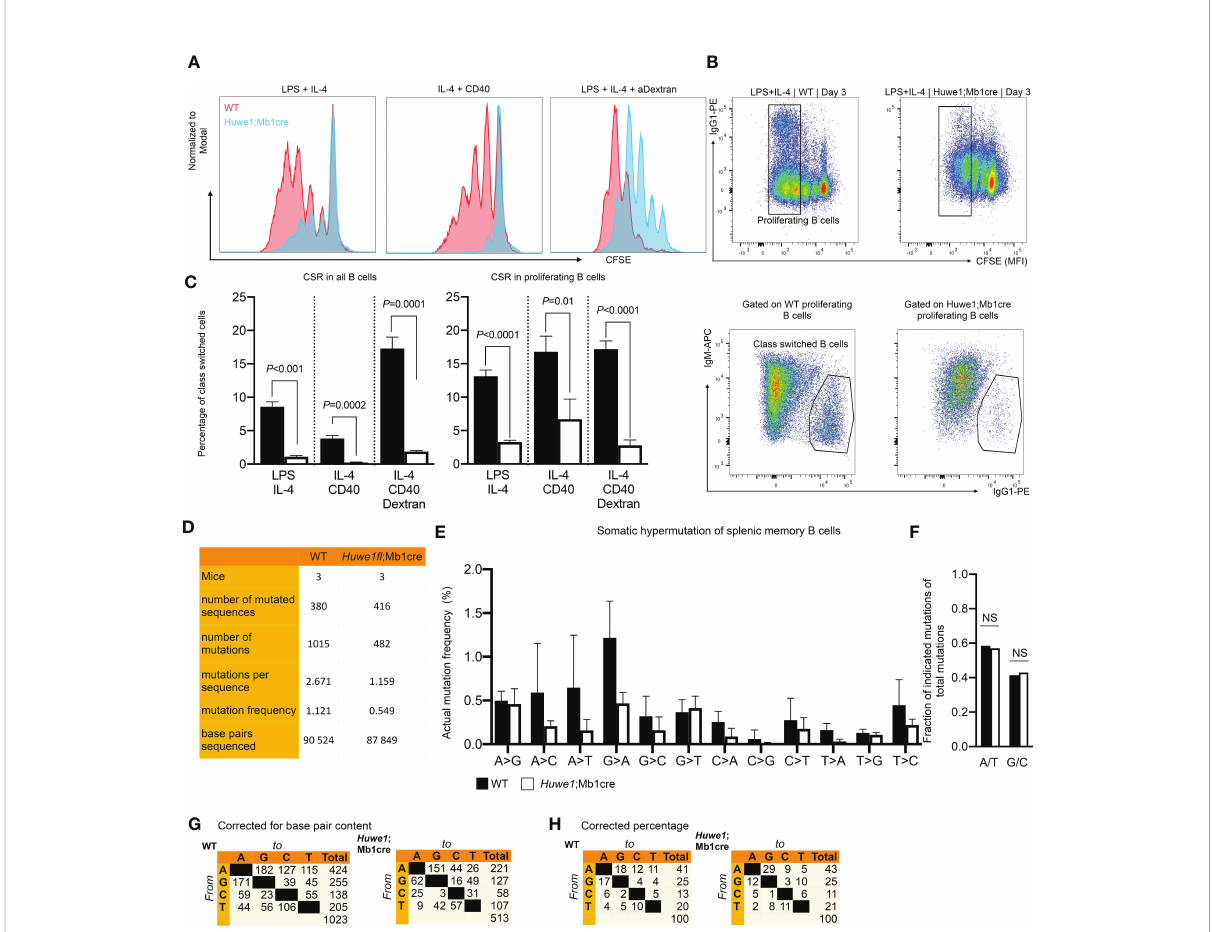
FIGURE 3 Reduced proliferation, class switch recombination (CSR), and somatic hypermutation. (SHM) in Huwe1 ;Mb1cre mice. (A Proliferation of activated B cells as measured by carboxy fl uoroscein succinimidyl ester (CFSE) labeling. Resting splenic B-cells were activated in vitro for 3 days as indicated and analyzed by fl ow cytometry. CFSE overlay histograms are shown. Splenic B cells from wildtype (WT) mice are depicted as